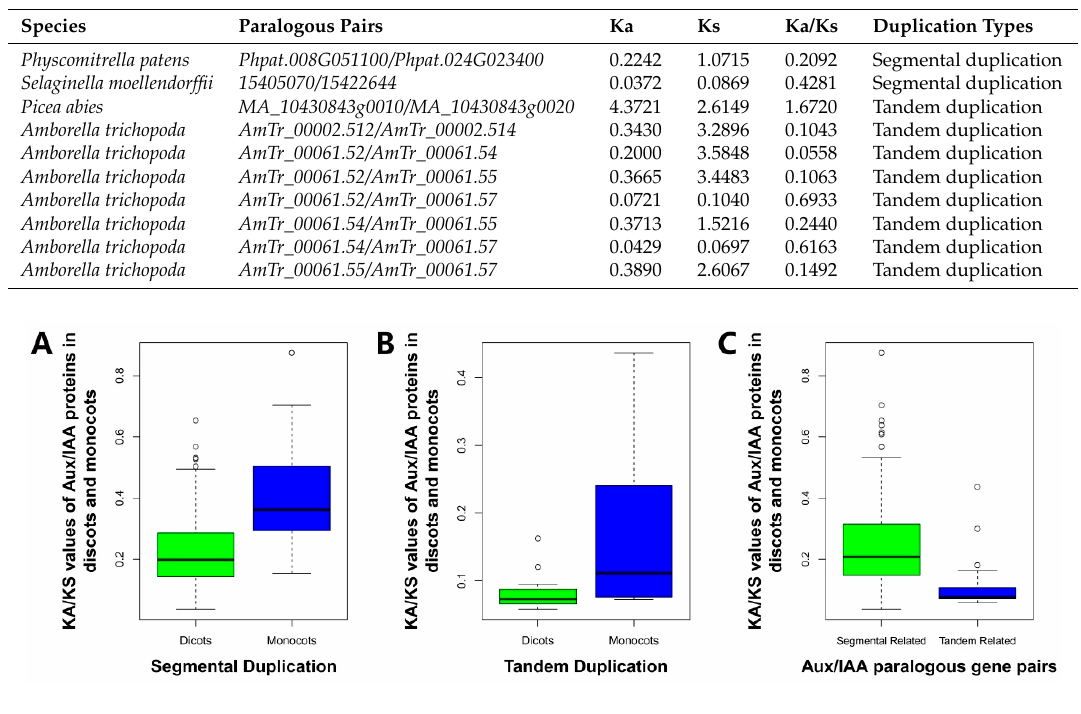
Figure 6. Molecular evolutionary rate of Aux/IAAs in the plant kingdom. ( A ) Rates of molecular evolution in segmental duplication of dicot and monocot Aux/IAA genes; ( B ) Rates of molecular evolution in tandem duplication of dicot and monocot Aux/IAA genes. Two gene pairs are excluded from the plot and exist in the above table; ( C ) Rates of molecular evolution in segmental duplication and tandem duplication in plants.